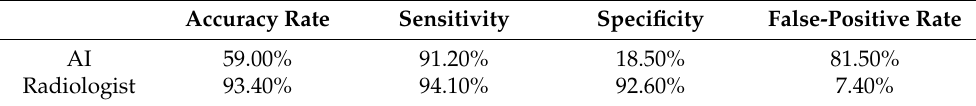
Table 2. Comparison between AI prediction results and radiologist prediction results.